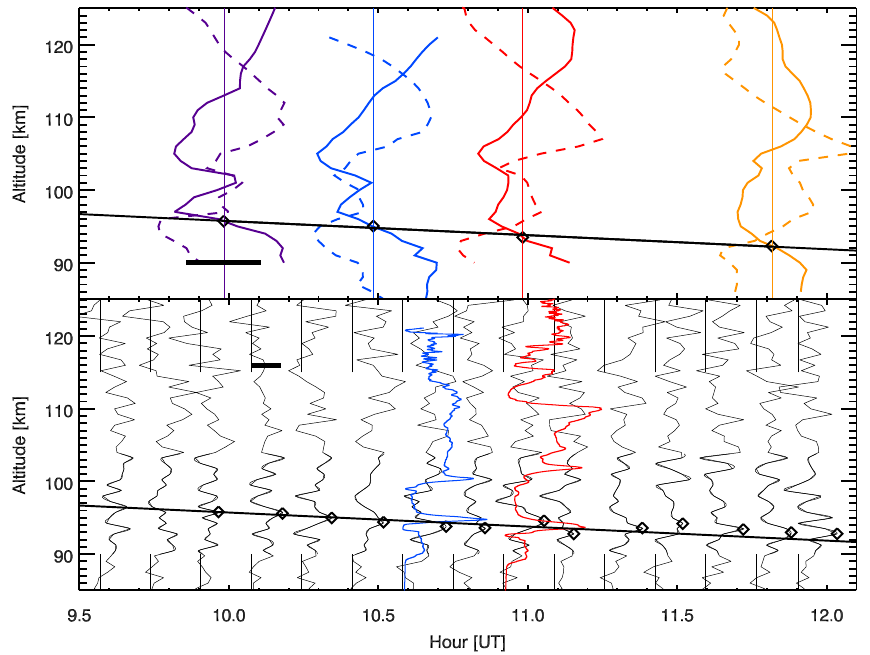
Figure 6. Top: zonal and meridional wind profiles (solid and dashed lines, respectively) from all four flights shifted according to the launch time (41.076 purple, 41.078 blue, 41.079 red, 41.077 yellow). The black bar at the first profile represents ± 50ms − 1 . The slanted line is a linear best fit (slope − 1 . 3 ( ± 0 . 3 ) kmh − 1 ) to the zonal wind node in the 95km region. Bottom: vertical profiles of electron density from PFISR (black) and nose-tip probes (blue and red) shifted in time. The scale is linear and the black bar at the fourth profile represents 1 × 10 10 m − 3 . Error estimates for PFISR are 1 to 6 × 10 9 m − 3 , increasing with altitude. The nose-tip probe profiles are scaled to match the radar-derived densities in the region below 100km. The diamonds mark the strongest local maximum near 95km, descending in altitude (best fit slope − 0 . 3 ( ± 0 . 5 ) kmh − 1 ). The straight line is again the fit to the wind nodes from the upper panel and is shown for comparison with the electron density